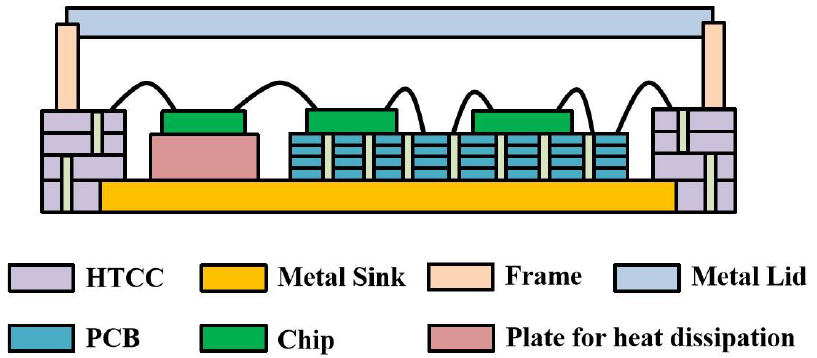
Figure 1. Diagram of the proposed SIP package structure.